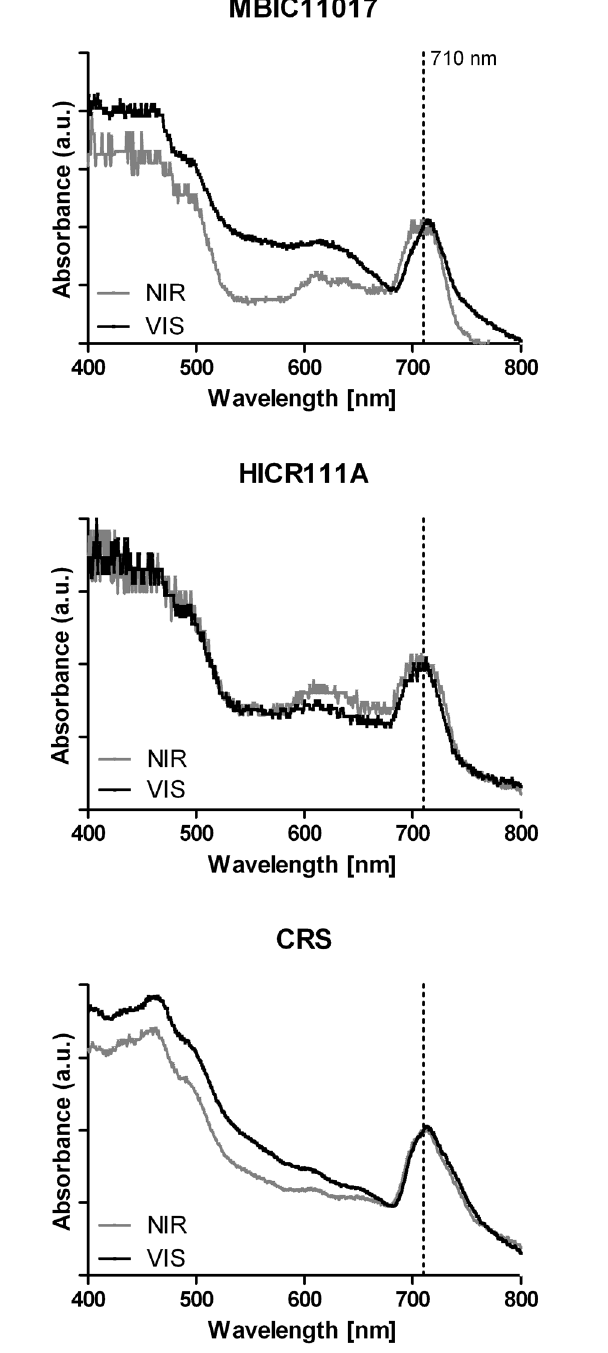
Figure 3. In vivo absorption spectra of the three Acaryochloris strains MBIC11017, HICR111A and CRS . All strains were adapted to either visible light (VIS) or near infrared radiation (NIR) prior to measurements. All spectra were normalized to the maximal absorbance of Chl d at 710